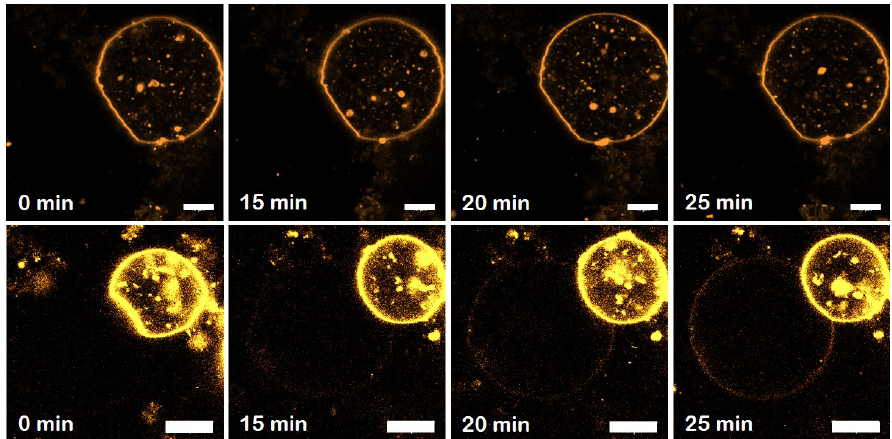
Figure 6. Time evolution of lipid mixing assay in GUVS bearing Mfn1-induced adhesion. Lipid mixing was monitored when fluorescence intensity was observed on the non-labelled vesicle after adhesion of two GUVs, one of them labelled with Rh-PE (0.5%mol). In 90% cases (N = 10) no fluorescence redistribution between vesicles was observed ( top row ). Only in one case, a fluorescent signal appeared in the non-labelled vesicle, suggesting lipid mixing ( bottom row ). Note that the equilibrium was only reached after 20–30 min. Scale bars are 10 µ